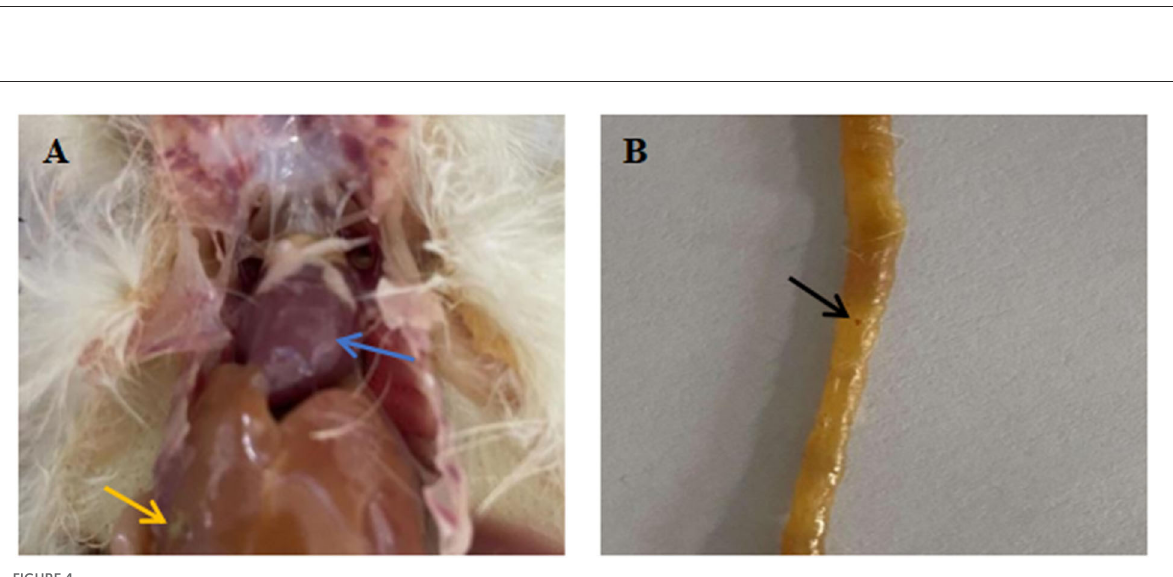
FIGURE4 Pathological anatomy of organs and intestines of chicks infected with Salmonella. (A) Pathological anatomy of organs. (B) Pathological anatomy of intestine. Blue arrow: fibrous exudation on the heart surface. Yellow arrow: the liver is swollen, yellowish brown, with gray white necrotic foci. Black arrow: there are obvious bleeding spots on the intestinal